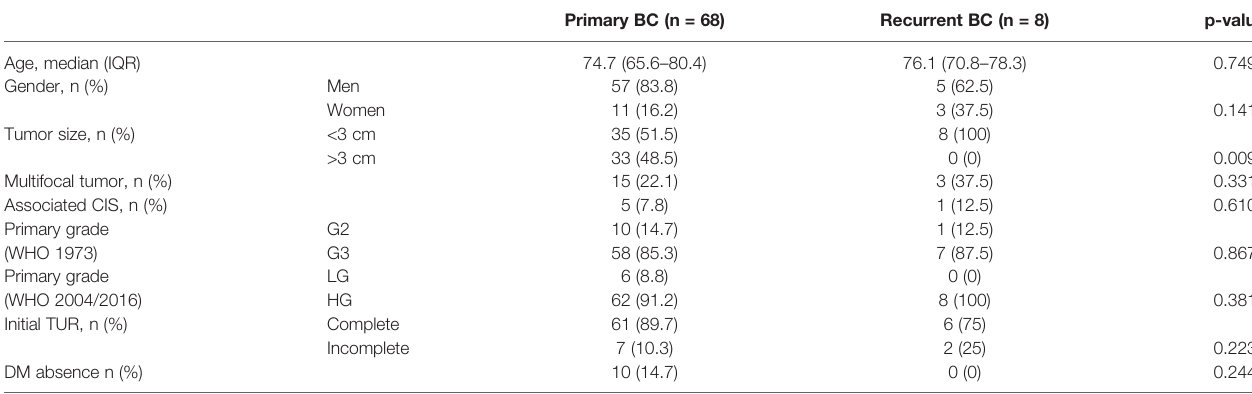
TABLE 2 | Characteristics of the patients strati fi ed by prior recurrence status (primary vs.